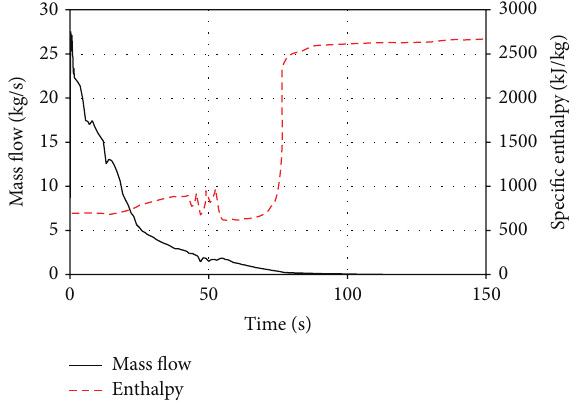
Figure 4: Coolant release rate and specific enthalpy to plasma vessel received from RELAP5 code analysis